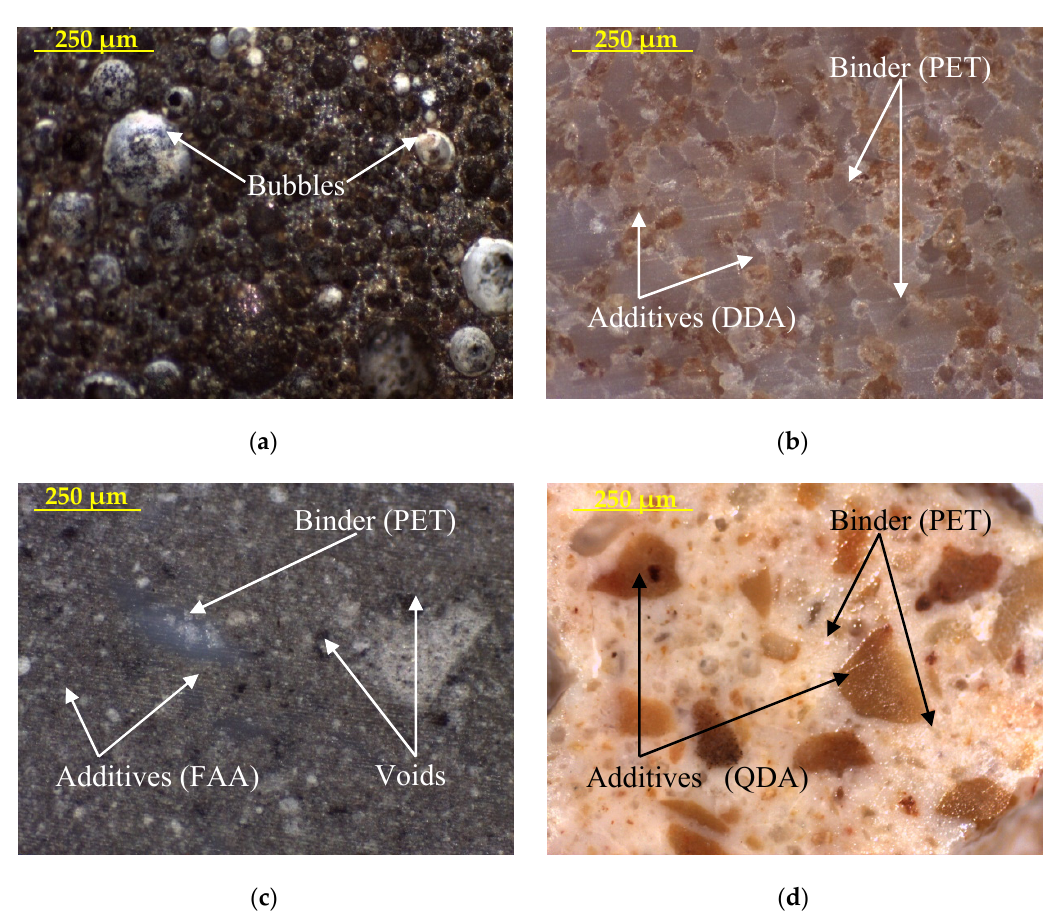
Figure 9. Optical microscopic images of ( a ) volcanic lightweight aggregate (VLA) and plastic based green lightweight aggregates (PGLAs) made with ( b ) dune dust additive (DDA), ( c ) fly ash additive (FAA) and ( d ) quarry dust additive (QDA).